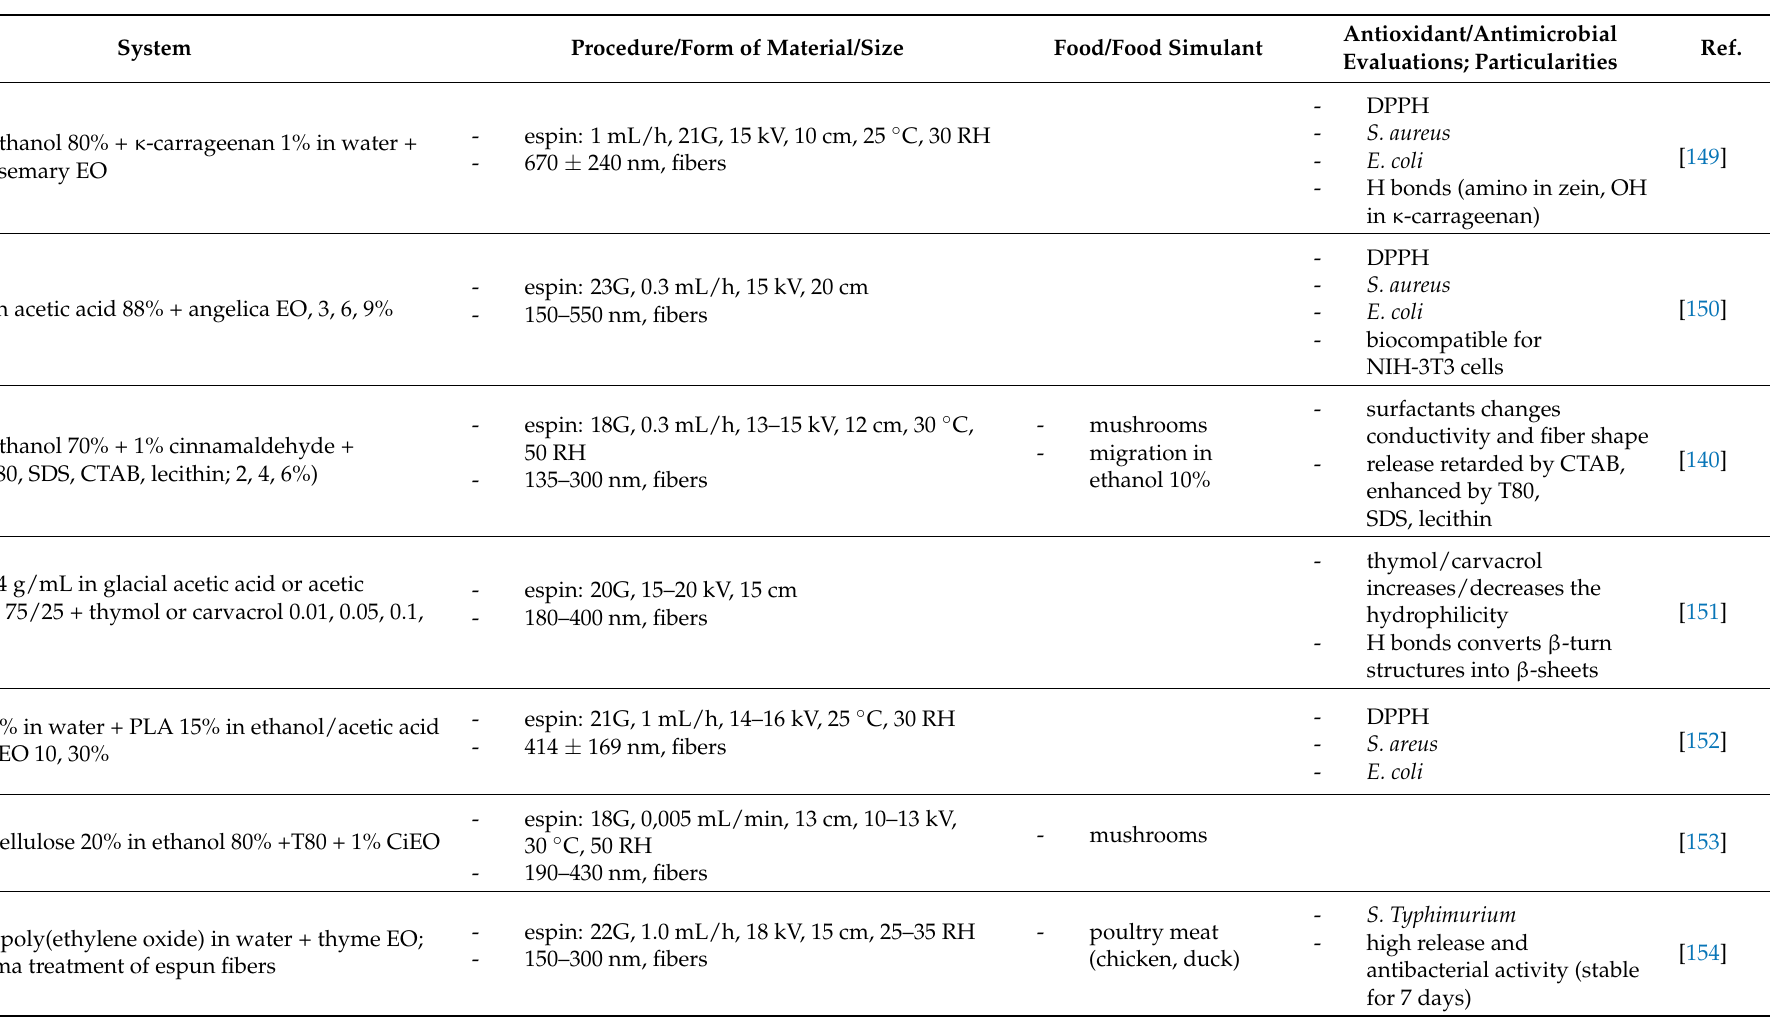
Table 2. Cont. Procedure/Form of Material/Size Food/Food Simulant